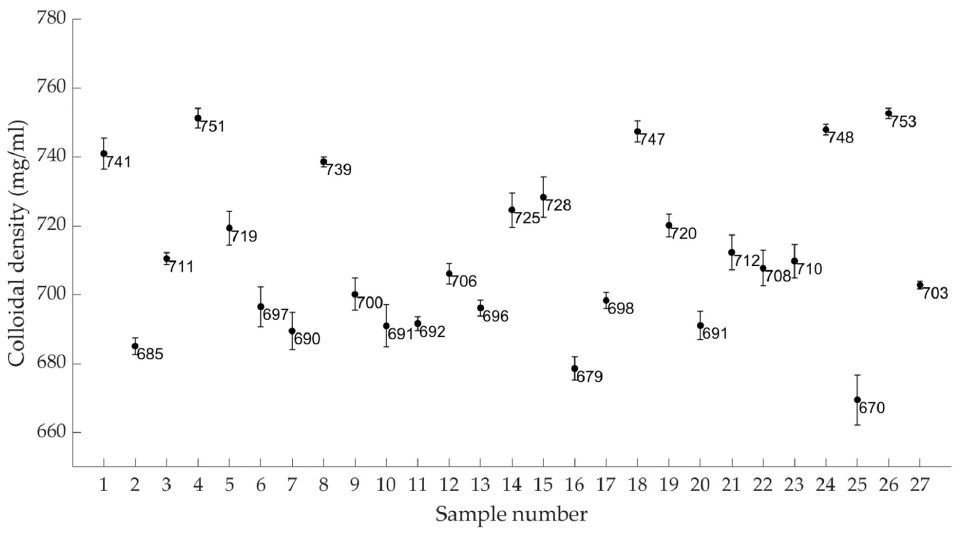
Figure 3. Mean colloidal density (mg/mL) per sample group (1–27) (95%